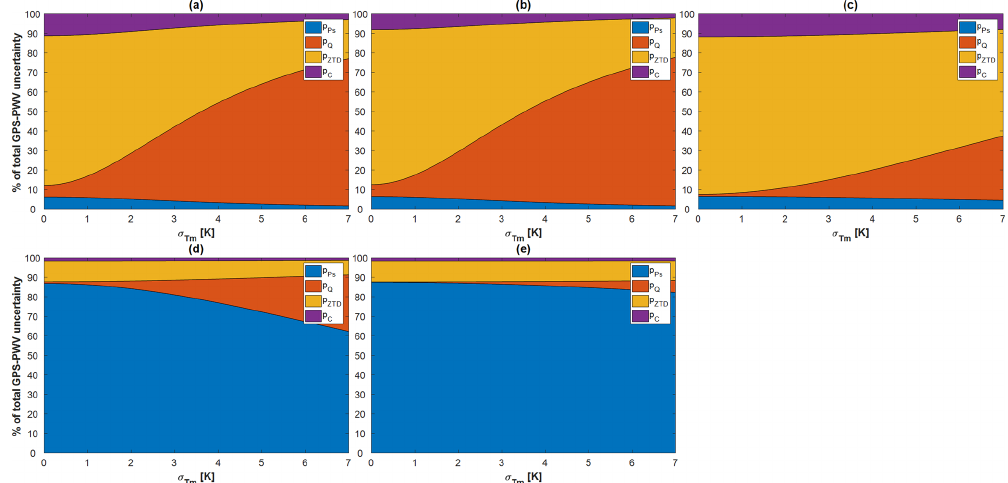
Figure 10. Contributions of different terms to the total uncertainty in GPS–PWV with the typical values shown in Table 4.